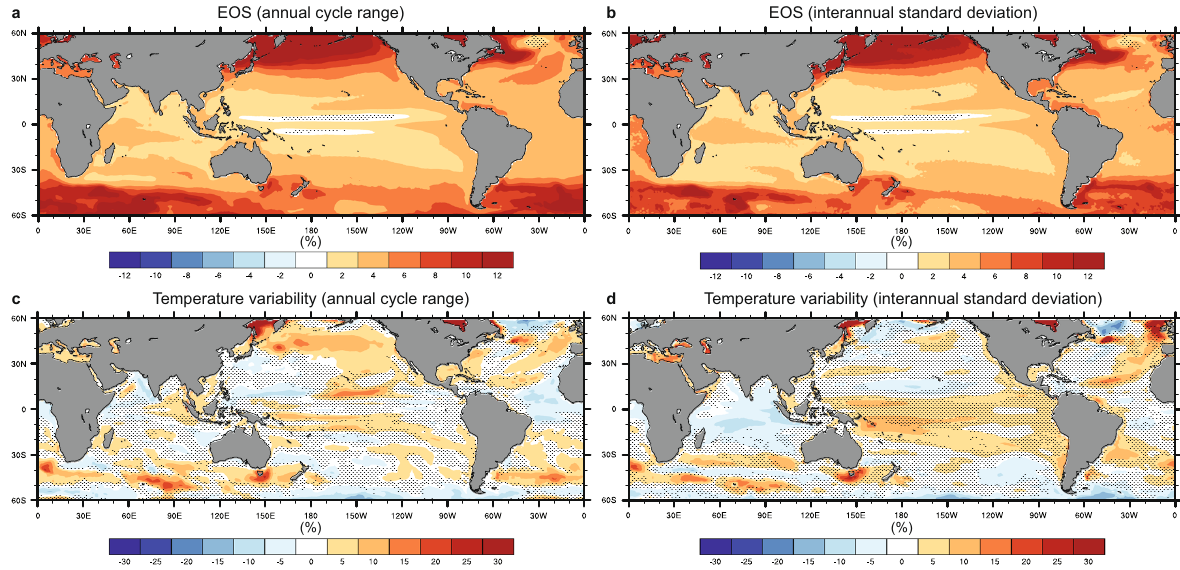
Fig. 4 Components of future projected changes (%) of CMIP5 multi-model mean SSH. a, b Changes associated with the seawater EOS of the annual cycle range and interannual standard deviation, respectively. c , d Similar respective changes associated with ocean temperature variability changes. a – d The changes are scaled by dividing each component by the total thermosteric sea level variability during the historical period (see inference calculation in the Methods). Stippling indicates grid points where less than 19 out of 29 models agree on the future change